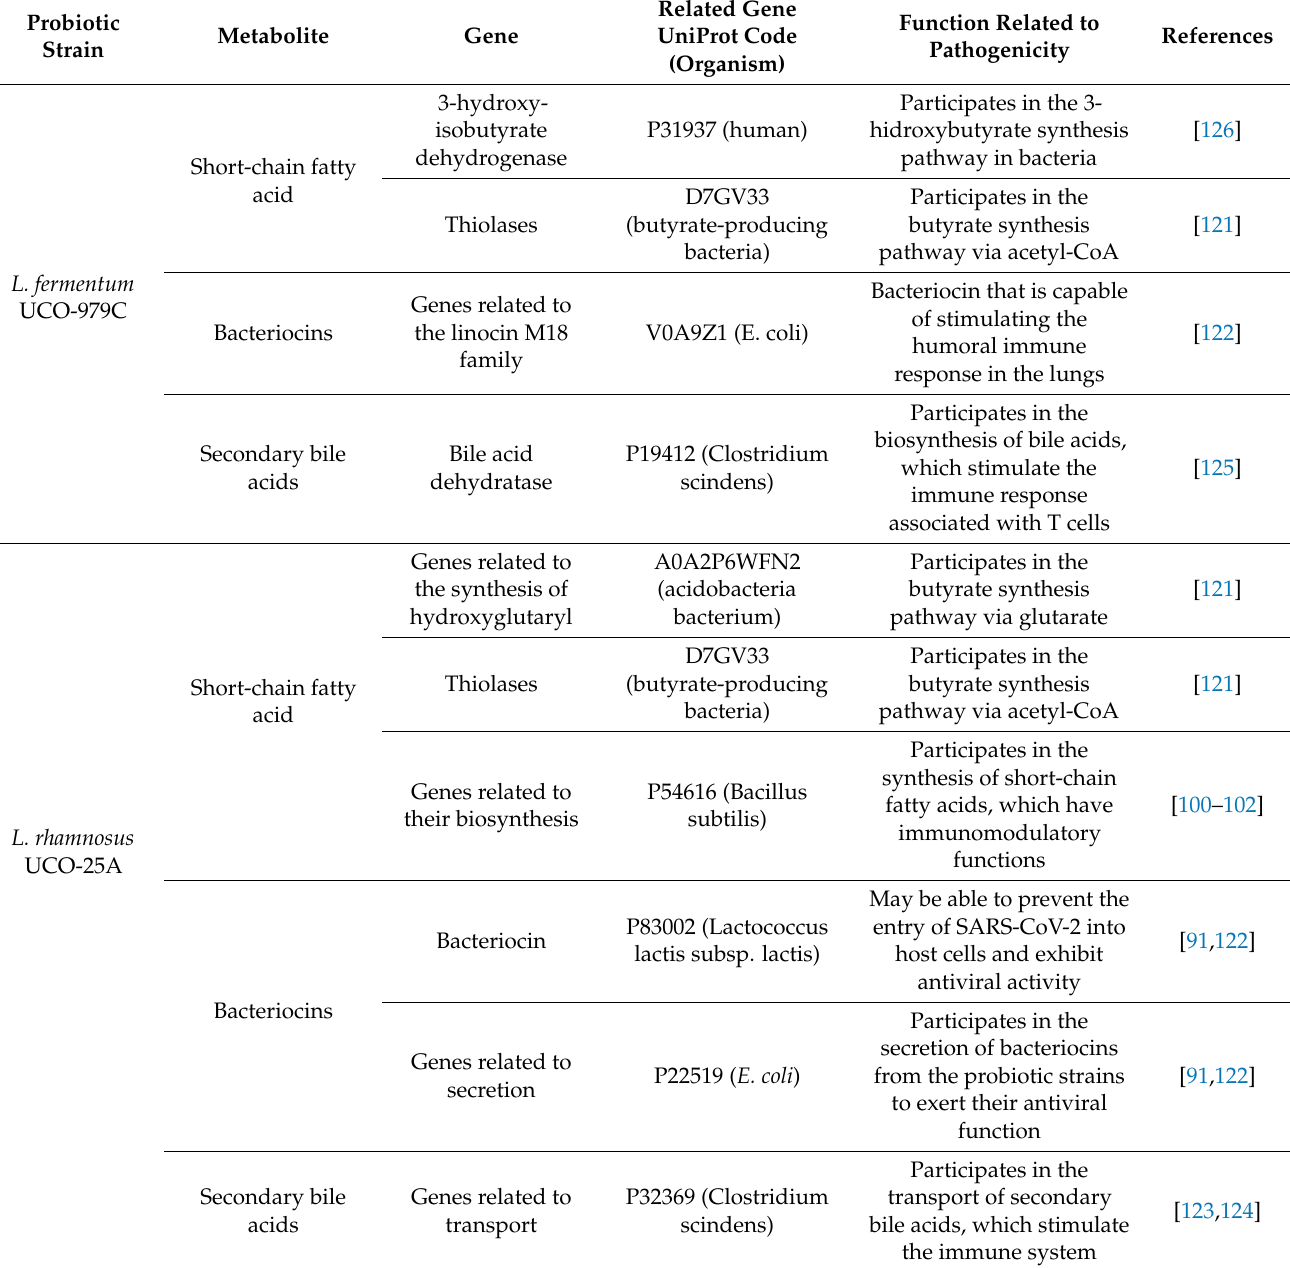
Table 3. In silico analysis of genes codifying the production of metabolites in L. fermentum UCO-979C and L. rhamnosus UCO-25A strains which could have an effect on infection by SARS-CoV-2